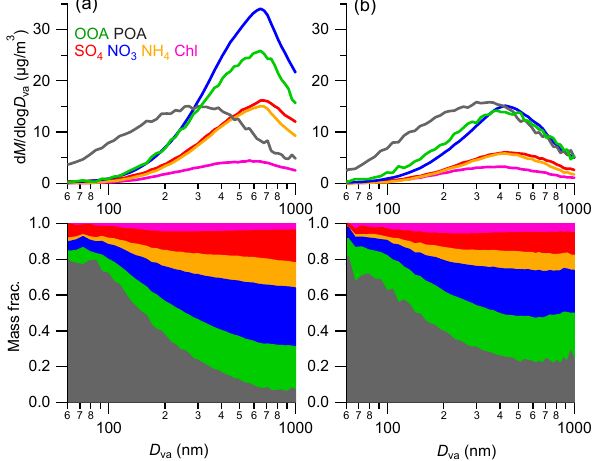
Figure 7. Average size distributions and fractions of NR-PM 1 species, primary organic aerosol (POA) and oxygenated organic aerosol (OOA) measured (a) before the Asia-Pacific Economic Co- operation (APEC) summit and (b) during